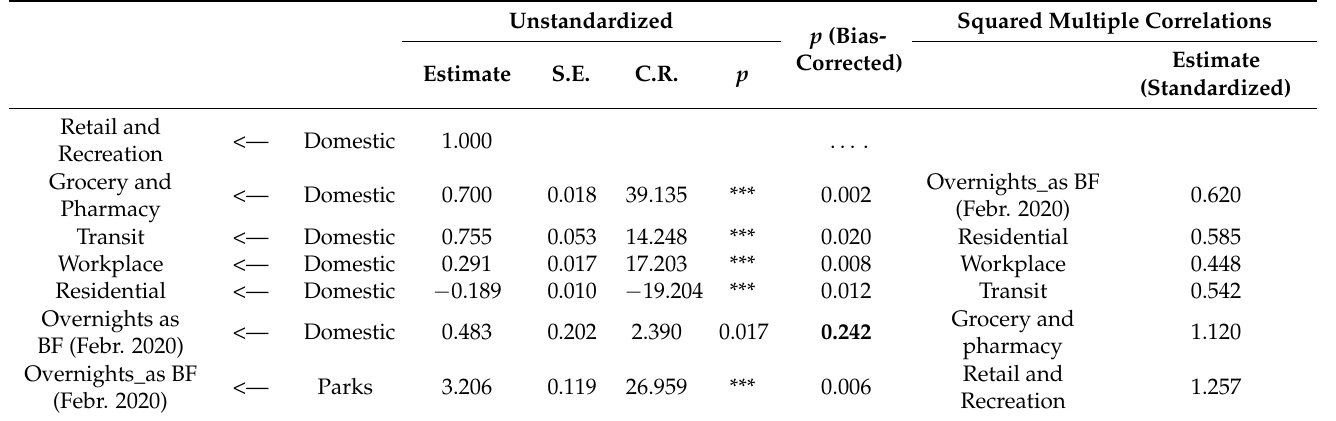
Table 7. Regression Weights and Squared Multiple